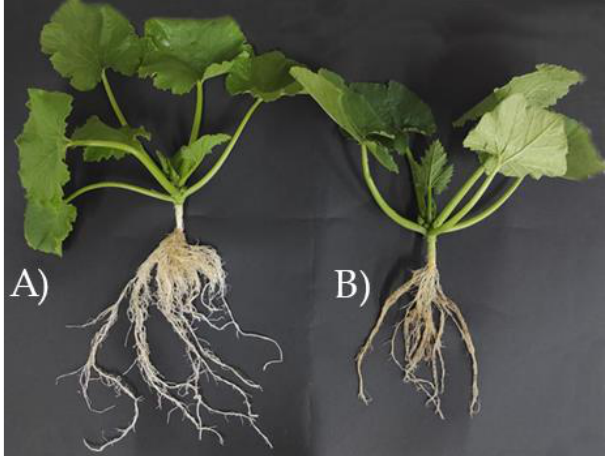
Figure 1. Zucchini plants 24 days after the inoculation. ( A ) Trichoderma harzianum T22 inoculated plant; ( B ) not inoculated control plant.